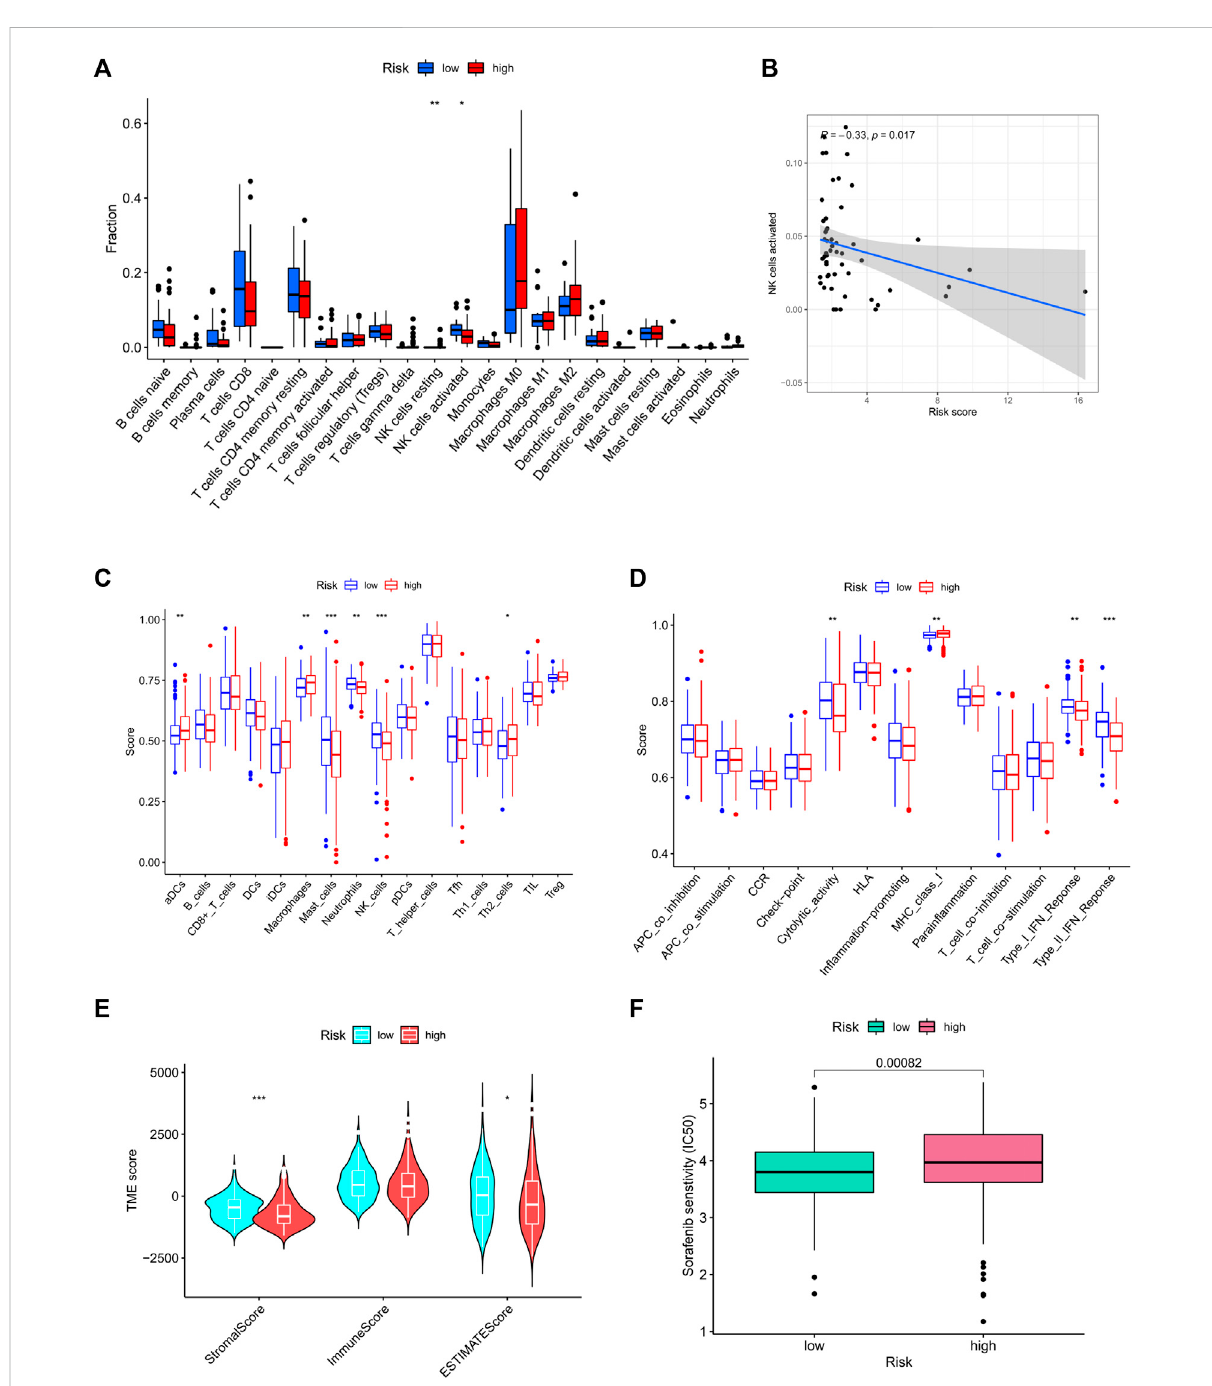
FIGURE 9 Immune cell in fi ltration in high- and low-risk groups. (A) The in fi ltrating levels of 22 immune cell types. (B) Correlation of NK cell level with risk score. (C) ssGSEAresultofimmunecellpopulations. (D) ssGSEAresultofimmunefunction. (E) Analysisoftumormicroenvironmentinhigh-andlow- risk groups; Drug sensitivity result. (F) IC50 value of sorafenib in high- and low-risk groups. ssGSEA: Single-sample gene set enrichment analysis; IC50: Semi-inhibitory